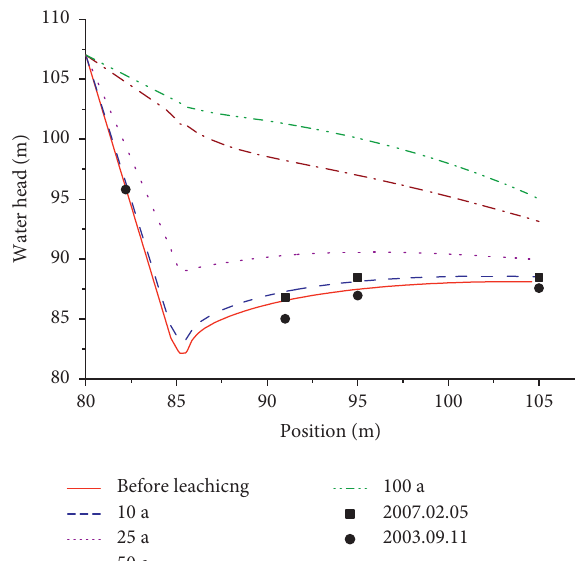
Figure 14: Evolution of the water head distribution along the dam baseline.